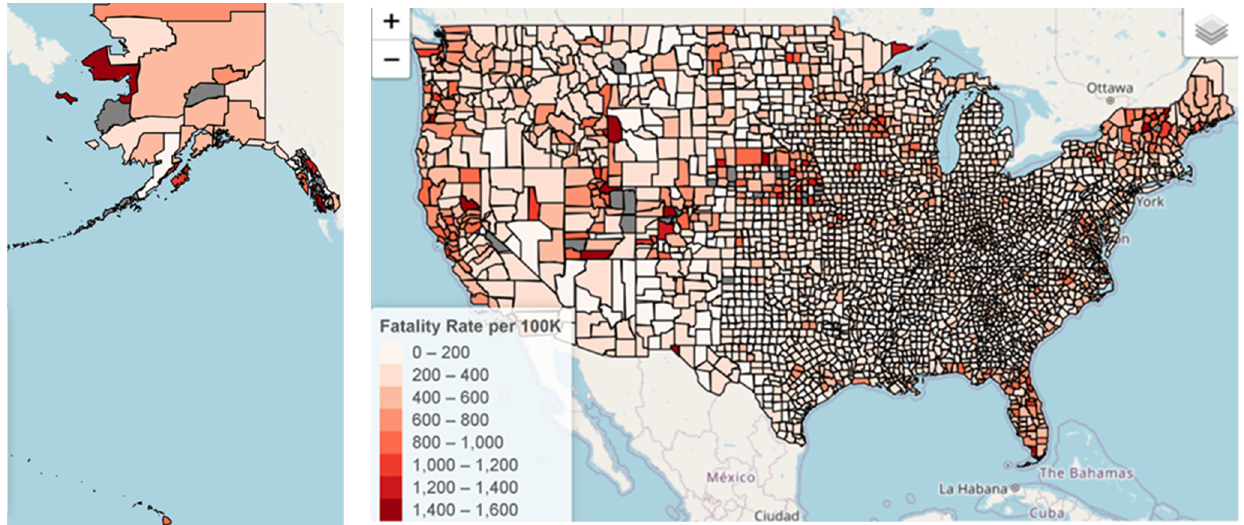
Figure 4. COVID-19 Fatality Rate per 100,000 population (county level). NOTE: counties in gray have in excess of 1600 fatalities per 100,000.